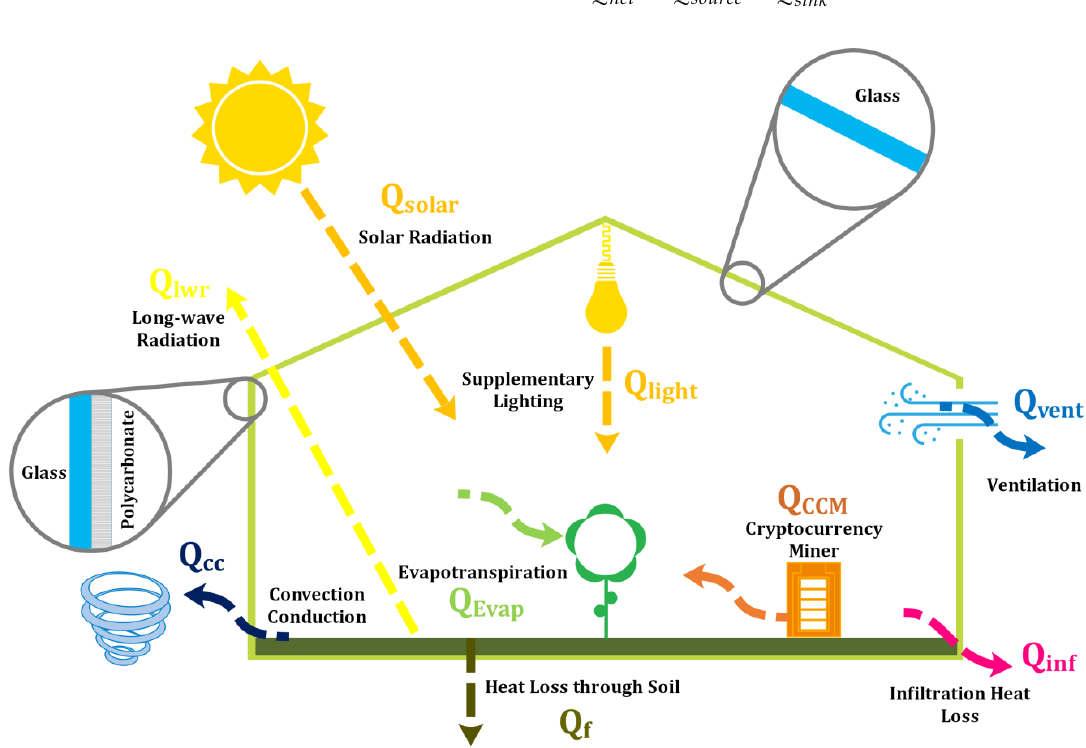
Figure 1. The schematic illustration of the heat sources and sinks in the greenhouse heated with a server or cryptocurrency miner.